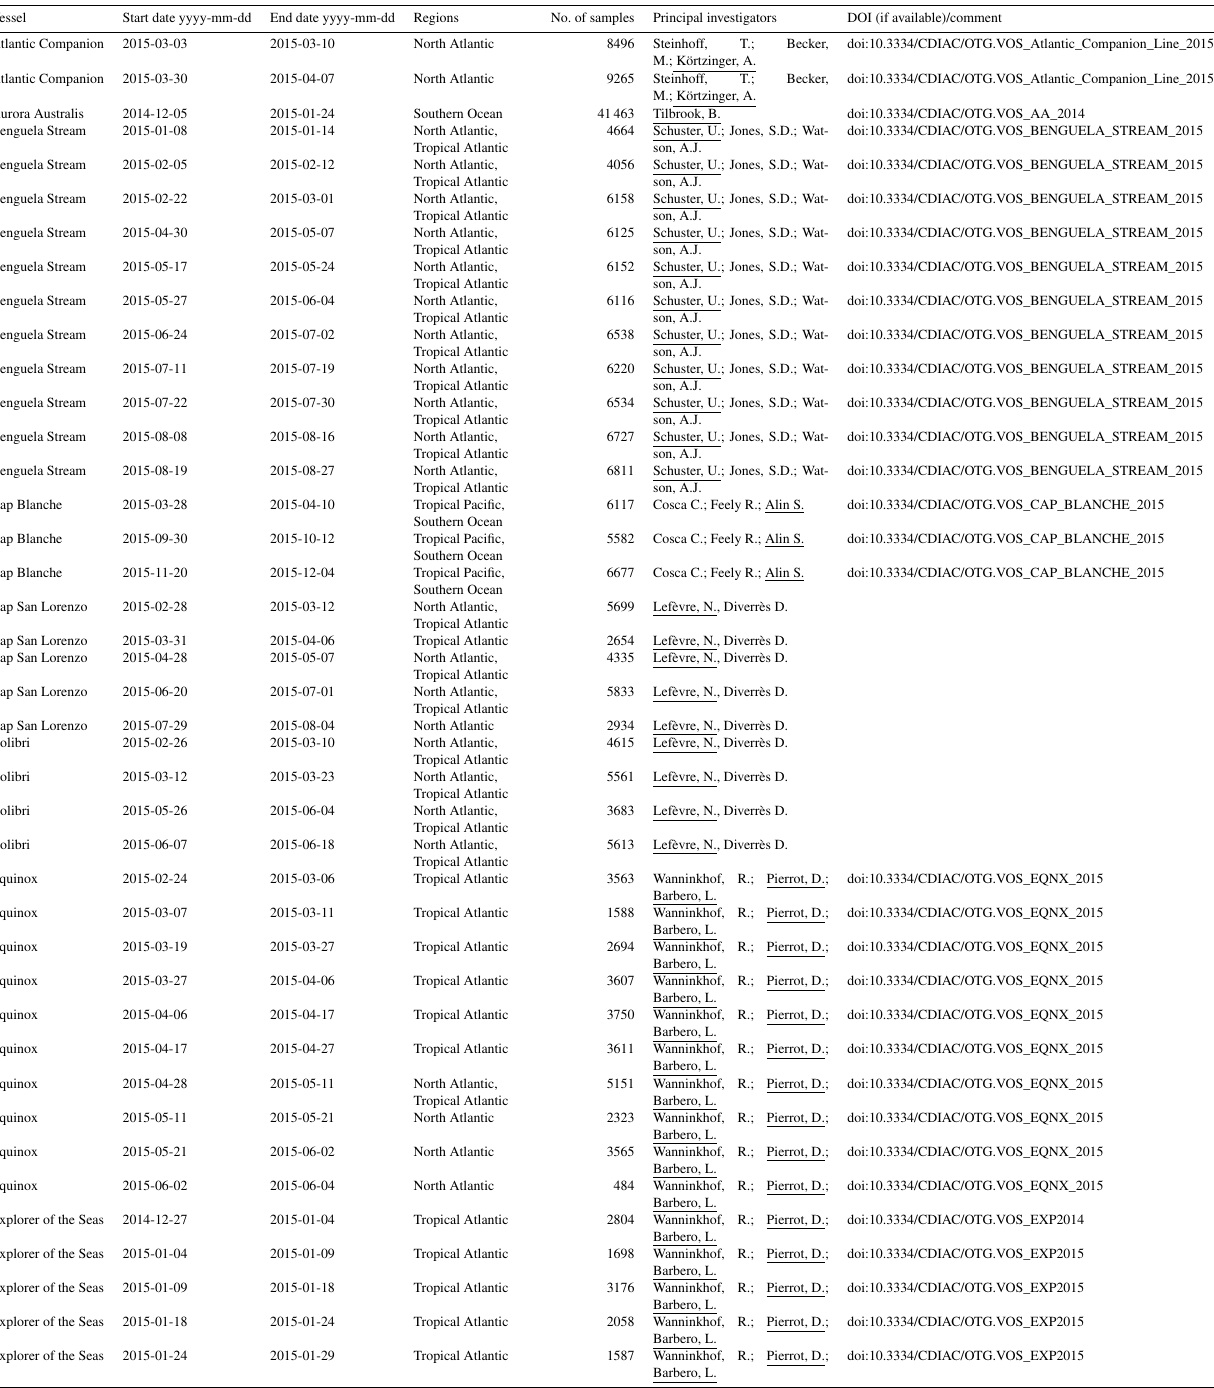
Table A1. Attribution of fCO 2 measurements for year 2015 included in addition to SOCAT v4 (Bakker et al., 2016) to inform ocean data